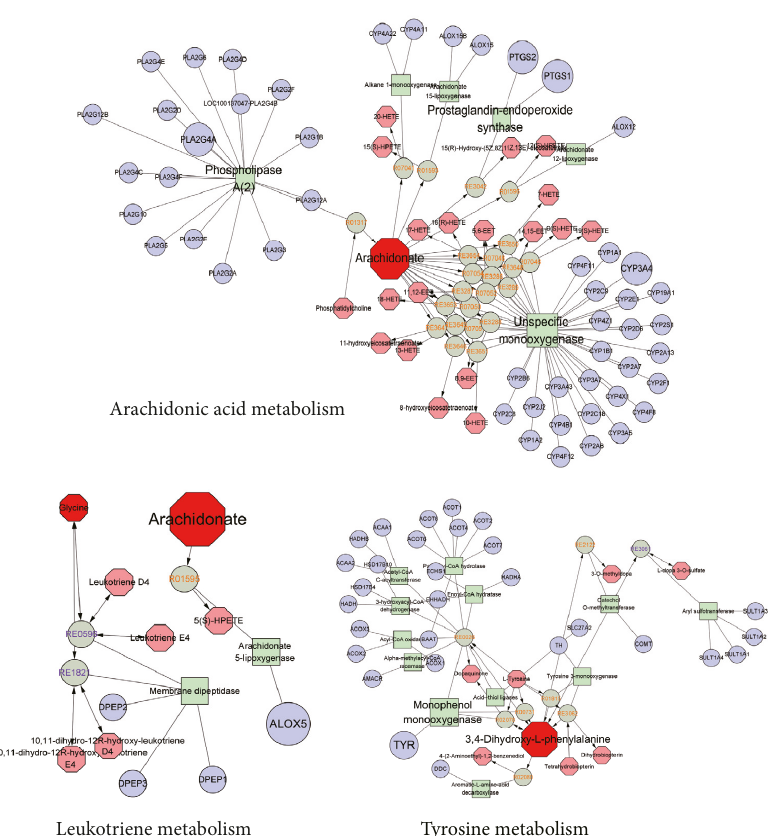
Figure 7: Compound-reaction-enzyme-gene networks of the key metabolites and targets. The red hexagons, gray diamonds, green round rectangles, and purple circles represent the active compounds, reactions, proteins, and genes, respectively. The key metabolites, proteins, and genes were magnified.